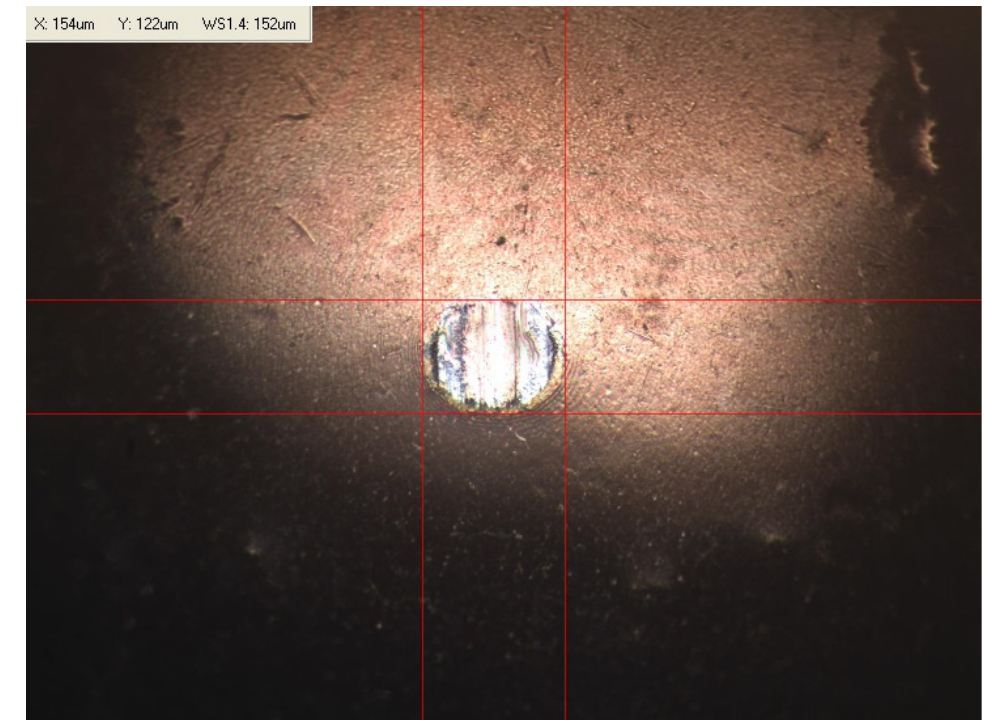
Figure A7. SAE 30—50% m/m; DO—50% m/m.